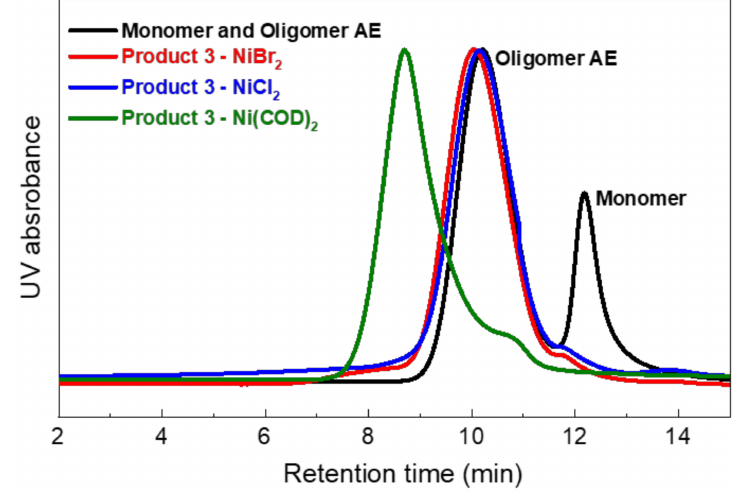
Figure 6. GPC traces of Product 3 synthesized using various nickel